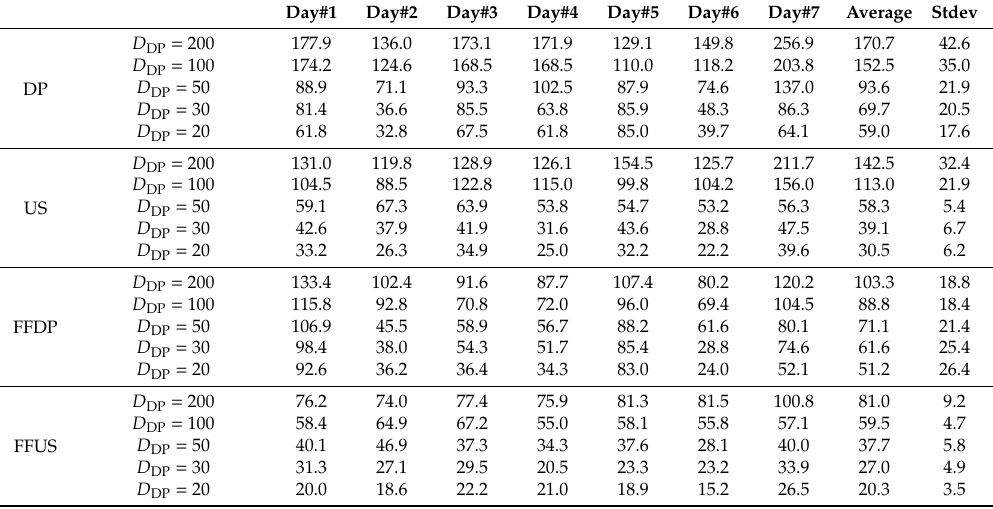
Table A2. Comparison of average SED of di ff erent simplification